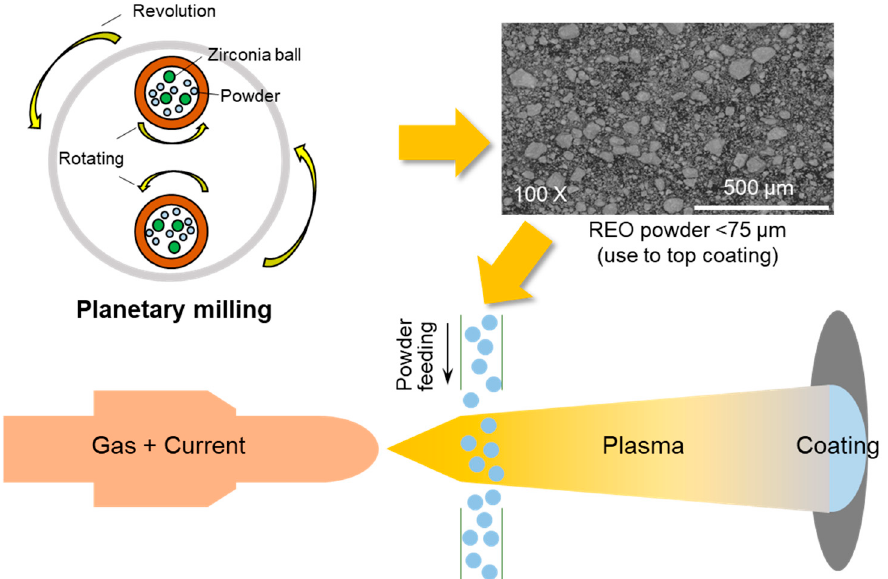
Figure 1. Schematic diagrams of the experimental methods.